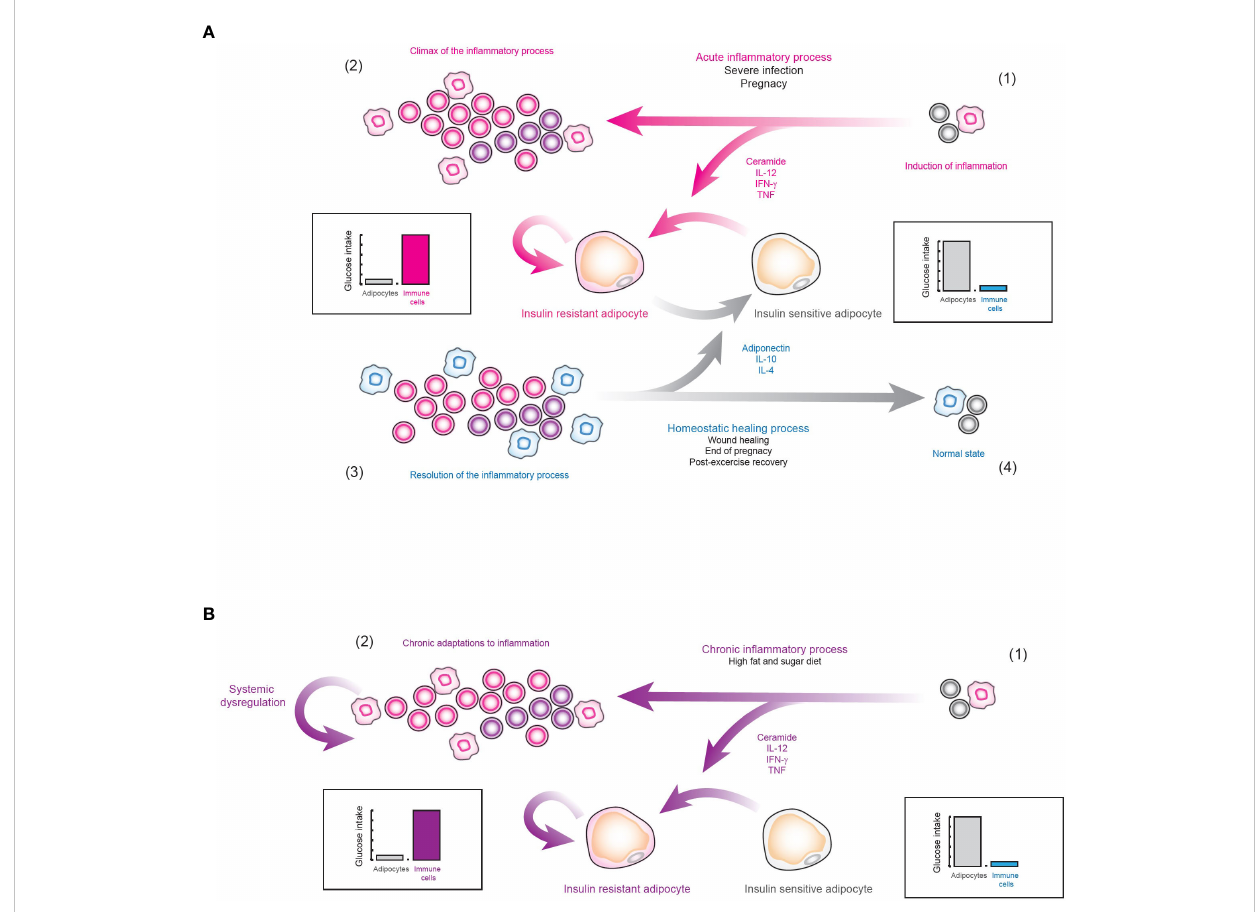
FIGURE 9 Hypothesis of the physiological role of insulin resistance. (A) Insulin resistance as nutrient redirecting mechanism. 1) When a strongly in fl ammatory stimulus is detected, the systemic release of pro-in fl ammatory cytokines is favored, which induces insulin resistance in cells responsive to this hormone, such as adipocytes. 2) In this way, the effector function of the immune system is enhanced, in order to neutralize the source of immunogenic signals. 3) After the pro-in fl ammatory stimulus is controlled, the body inhibits in fl ammation. 4) As a result, many anti-in fl ammatory cytokines such as IL-4 and IL-10 are released along with hormones such as adiponectin, which together inhibit in fl ammation and block intracellular ceramide signaling. Consequently, insulin resistance is eliminated and systemic homeostasis is restored. (B) Type 2 diabetes mellitus. 1) As a result of an alteration in the normal in fl ammatory levels of VAT due to diets rich in sugar and fat, the nutrient redirection mechanism controlled by insulin resistance is locally activated. 2) In consequence, the organism does not process this as a highly in fl ammatory stimulus. Instead, it processes this type of in fl ammation as normal VAT behavior, favoring physiological adaptations to chronic in fl ammation. Consequently, tissue regeneration processes are not activated and this pathological state continues inde fi nitely, producing type 2 diabetes